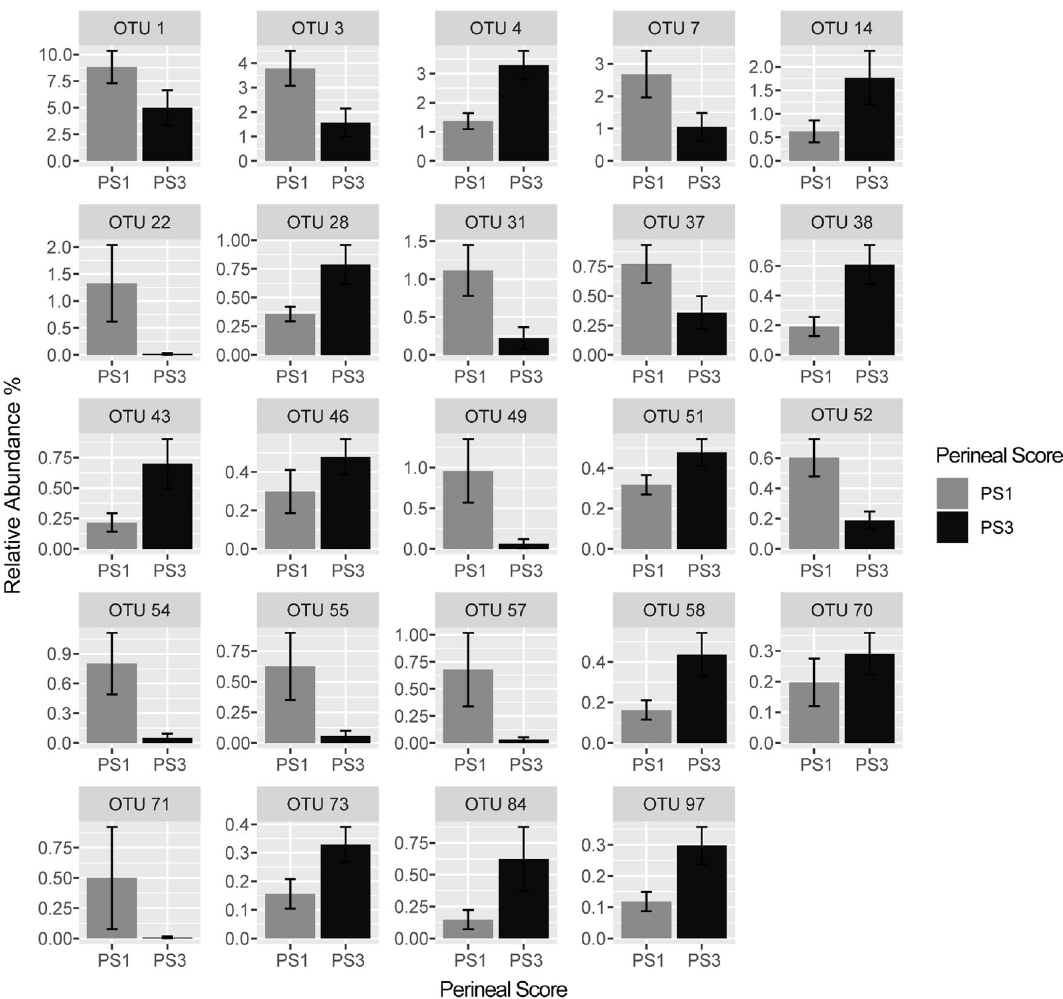
Figure 4. Different OTUs in the vaginal microbiota of sows with different perineal scores (PS). Significantly different ( P < 0.05) OTUs were identified with LEfSe. Only significant OTUs within the 100 most abundant are shown. Error bars represent the standard error of the mean. Out of all significantly different OTUs, 24 were considered significantly different among the 100 most abundant OTUs. Out of these 24 OTUs, 12 were more abundant in PS1 animals and 12 were more abundant in PS3 animals. See Table 1 for more